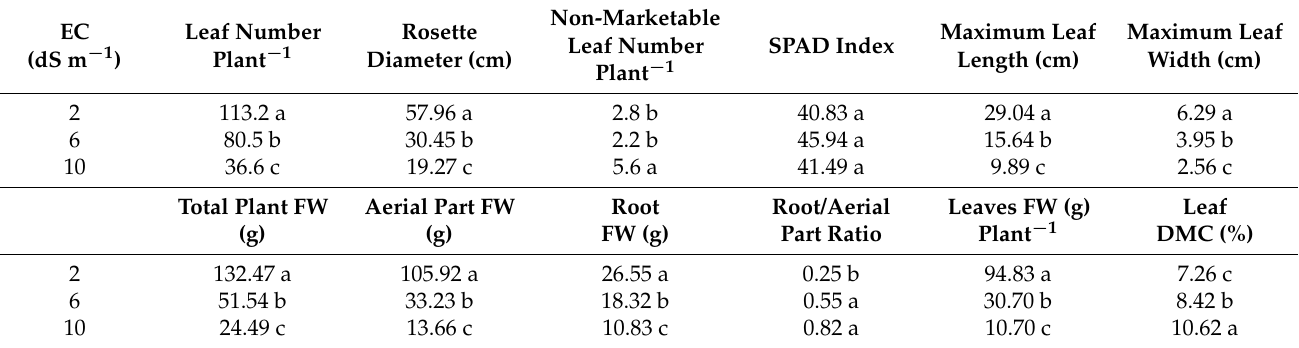
Table 1. Growth parameters of Hedypnois cretica plants grown under different electrical conductivity (EC) levels (2, 6, and 10 dS m − 1 ).